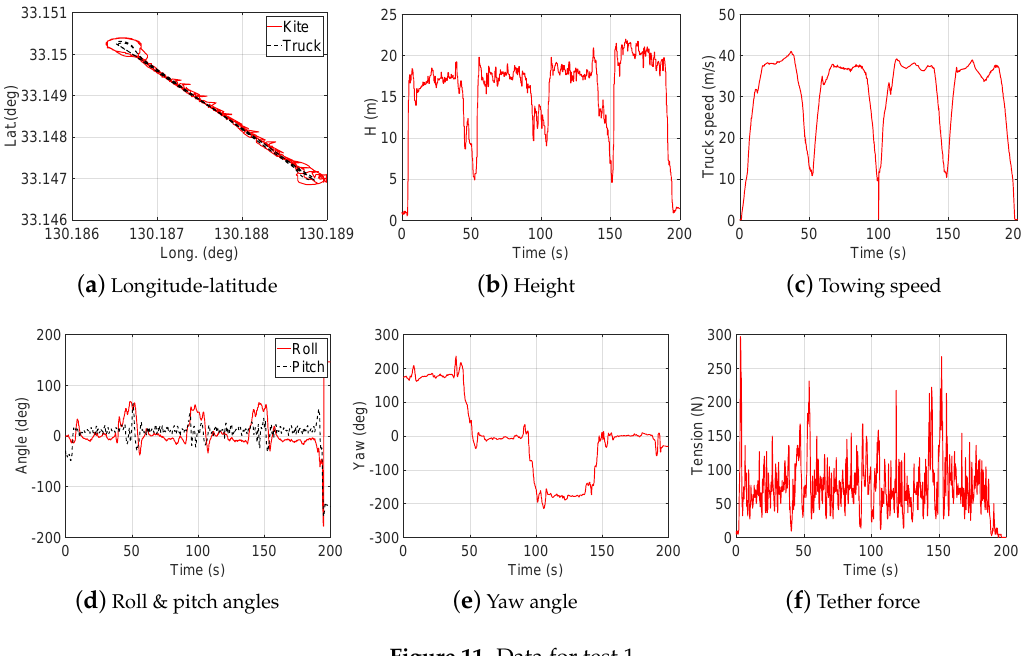
Figure 11. Data for test 1.